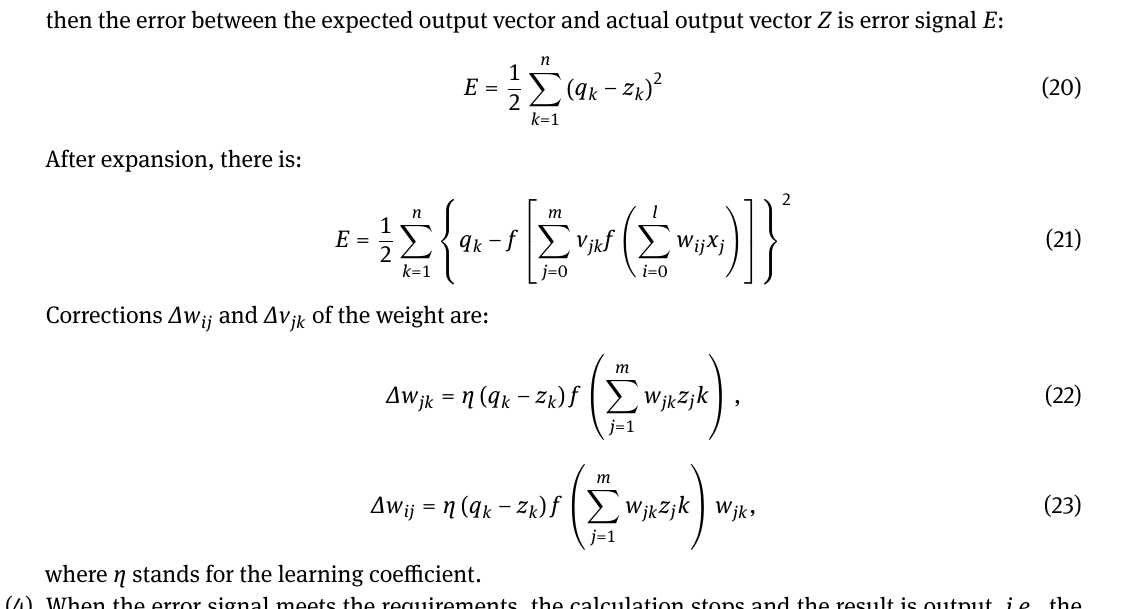
Figure 2: The image of the target